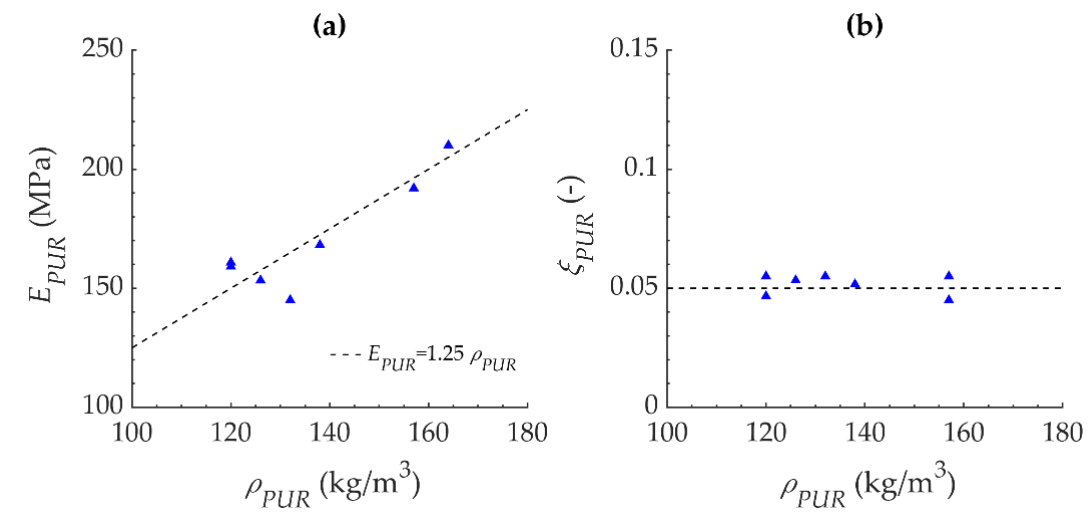
Figure 9. Parameters obtained from the elaboration of impact test results. Variation with polyurethane density of ( a ) the elastic modulus and ( b ) the damping coefficient.